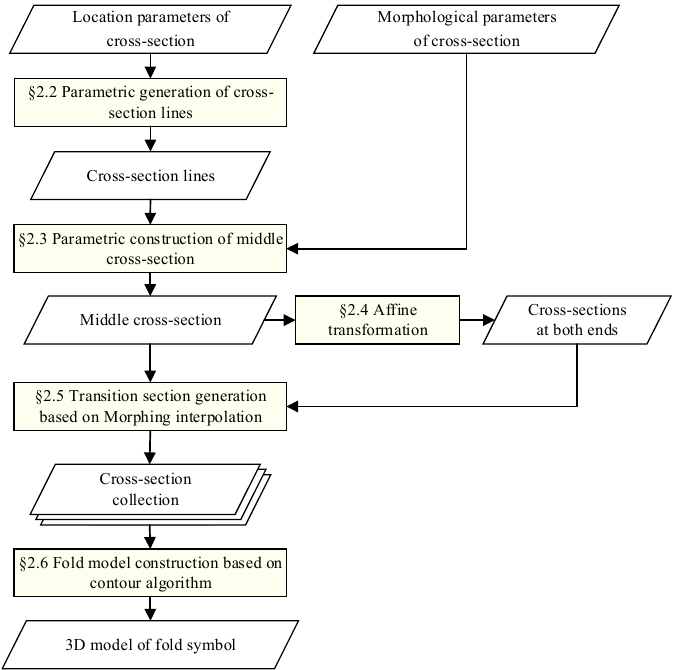
Figure 2. Parametric modeling process of 3D fold symbols.